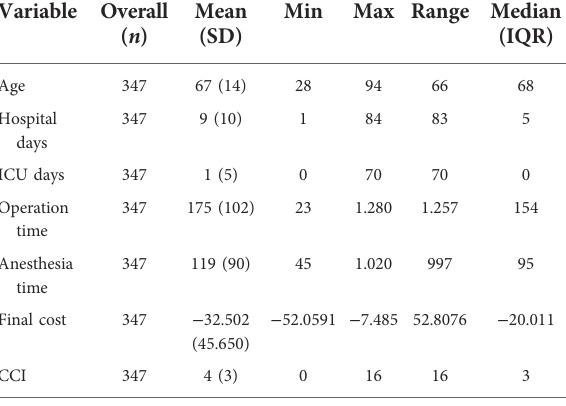
TABLE 1 Variable characteristics for continuous